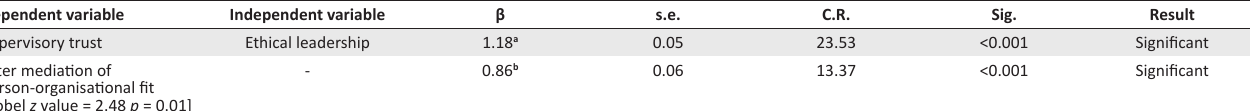
TABLE 5: Results of Baron and Kenny’s procedure (supported by Sobel z score) – the relationship between ethical leadership and supervisory trust through the mediation of P-O fit. Dependent variable